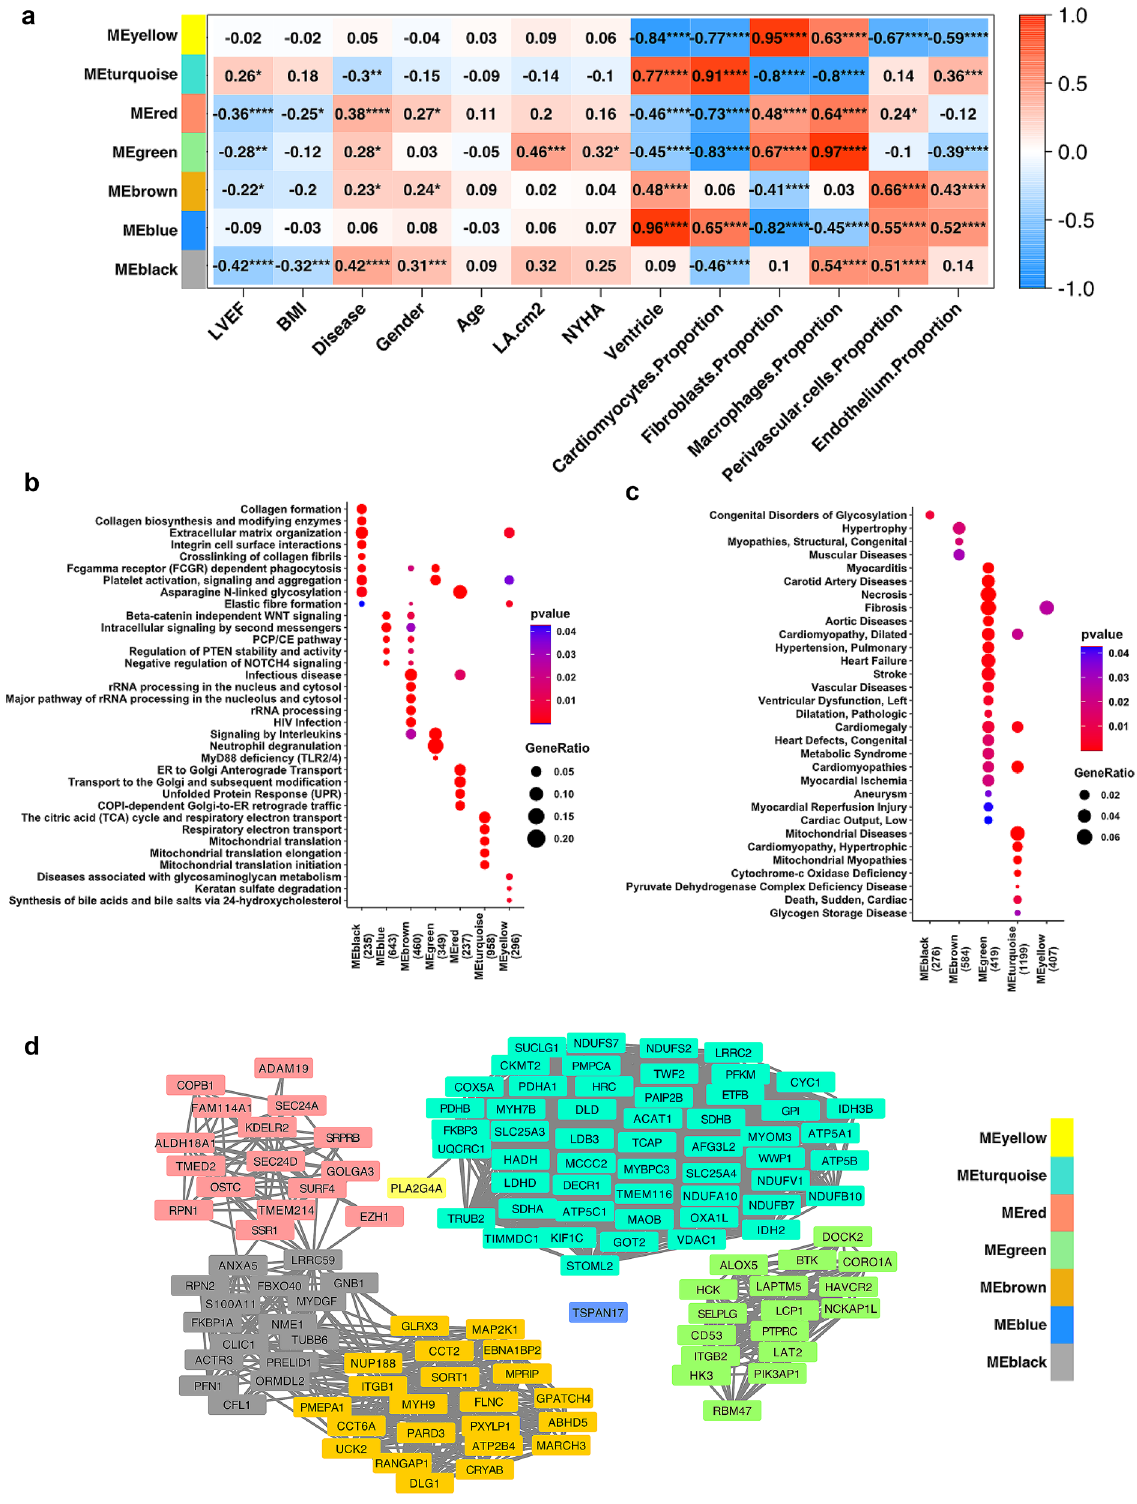
Figure 7. Network analysis revealed key modules and genes altered in HFrEF-diseased heart. ( a ) WGCNA analysis classified genes into 7 major modules. The heatmap shows the correlation score between each of the gene modules with the analyzed sample and clinical feature groups (* p < 0.05, ** p < 0.01, *** p < 0.005, **** p < 0.001). Comparison of over-representative ( b ) Reactome pathways and ( c ) cardiometabolic diseases associated MeSH terms among modules determined by WGCNA analysis. The size of the dot reflects the GeneRatio (the proportion of genes from list of interests that maps to the pathway) and the color of the dot indicates increasing significance of the enriched pathways from blue to red. Number of chamber enriched genes that overlap with the over-representative pathways are shown in parenthesis. Significantly enriched terms are presented in ( b,c ) and significance is indicated as p < 0.05. ( d ) Disease-associated hub genes ( p < 0.05) with top connectivity are visualized by Cytoscape. Color of each node corresponds with the module color in ( a